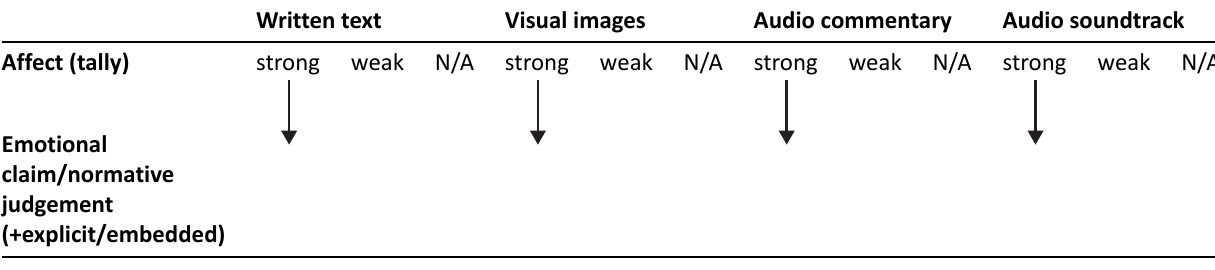
Table 3. Schema of affective and emotional